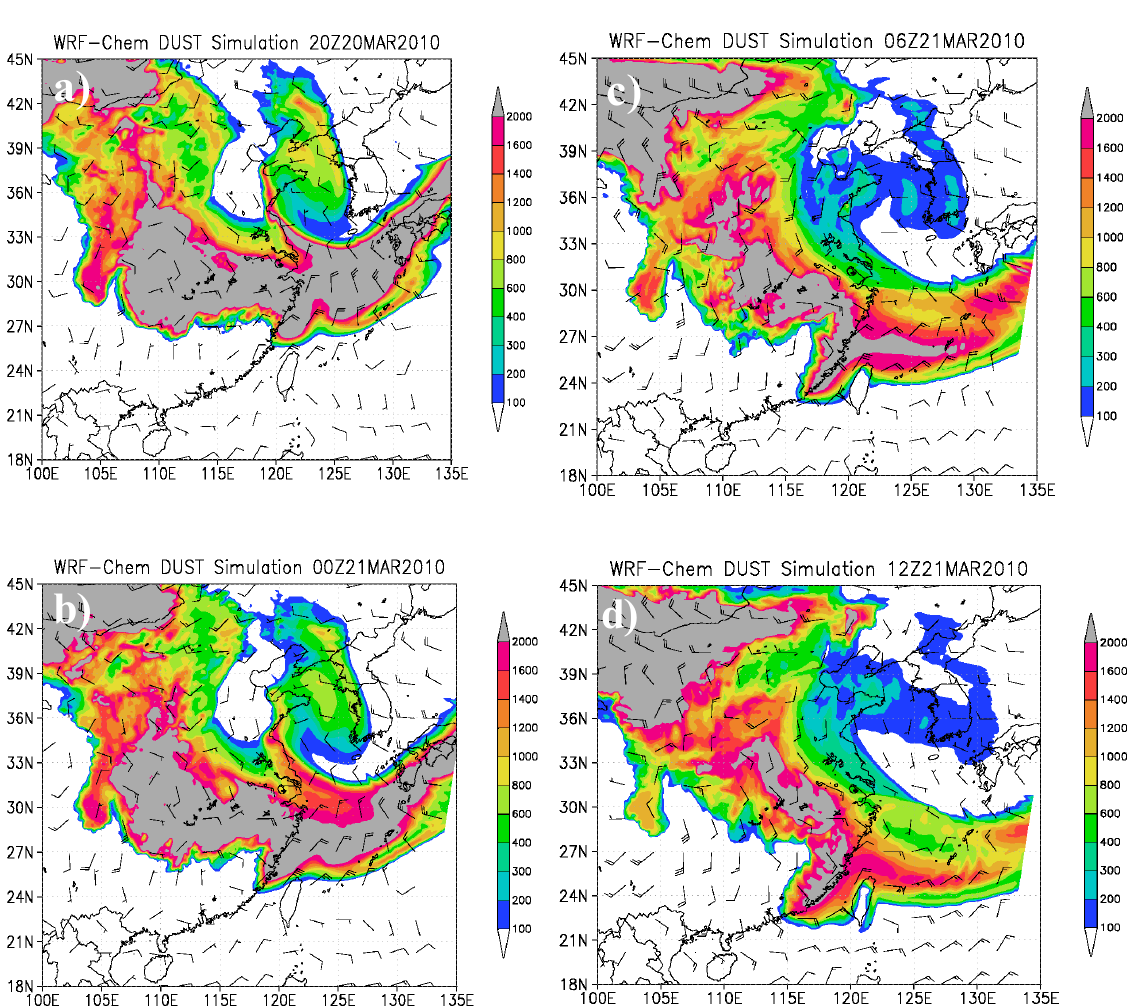
Fig. 7. The simulation spatial distribution of PM 10 concentration and wind field at 1000hPa. A full (half) wind barb indicates 5ms −